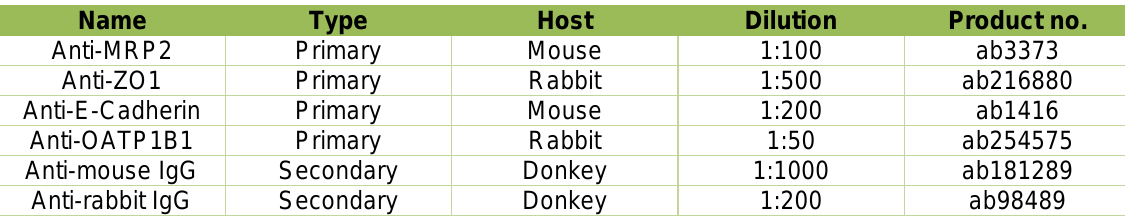
Table 5: Antibodies used for immunofluorescence staining